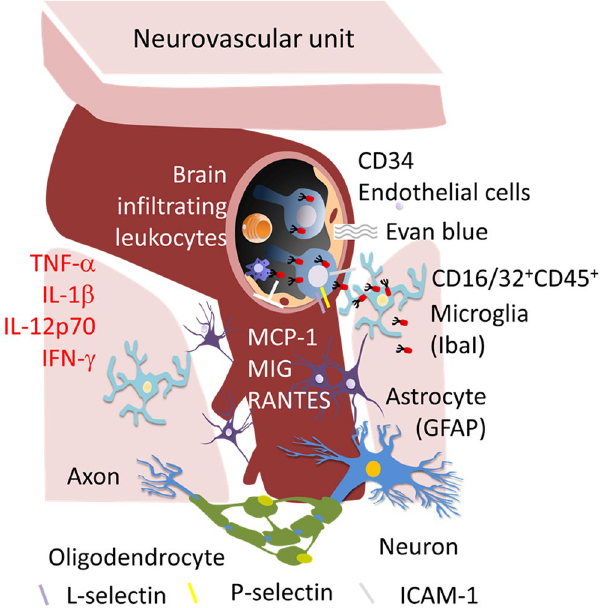
Figure 7. Summary of the Trojan horse mechanism that is activated during endotoxemia. During endotoxemia, the levels of brain cytokines (TNF- α , IL-1 β , IL-12p70 and IFN- γ ), chemokines (MCP-1, MIG, and RANTES) and CAMs (L-selectin, deep gray; P-selectin, yellow; and ICAM-1, light gray) were increased. GFAP-expressing astrocytes and Iba-1-expressing microglia were activated. In the neurovascular unit, of the number of endothelial CD34 cells, the degree of vascular permeability as measured by Evan’s blue, and brain leukocyte infiltration were increased. Neurologic melioidosis is induced via B. pseudomallei -load Ly6C cells (circulating CD16/32 + CD45 + cells) but is not induced via free B. pseudomallei